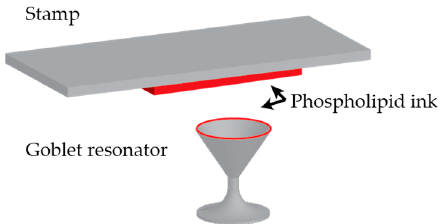
Figure 6. Goblet resonators are functionalized with a phospholipid “ink” using a stamping procedure which allows for each resonator in to be functionalized with a different capture agent in a parallel fashion.